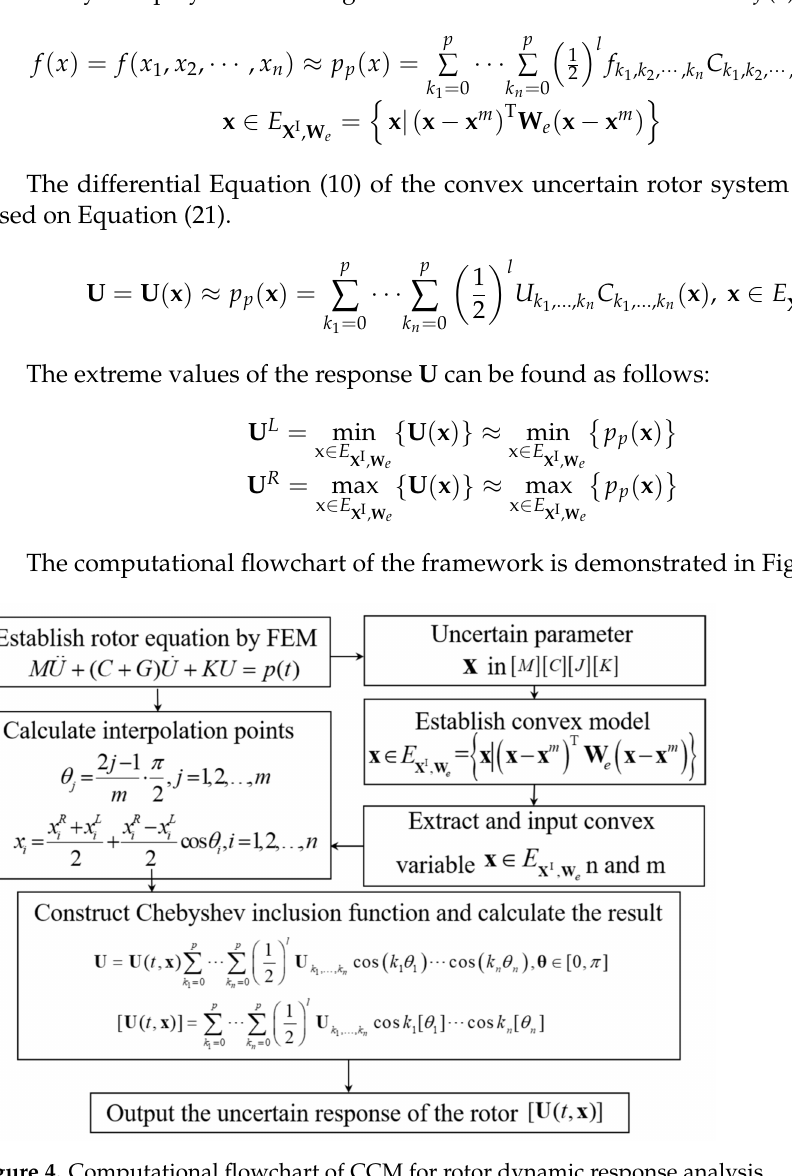
Figure 4. Computational flowchart of CCM for rotor dynamic response